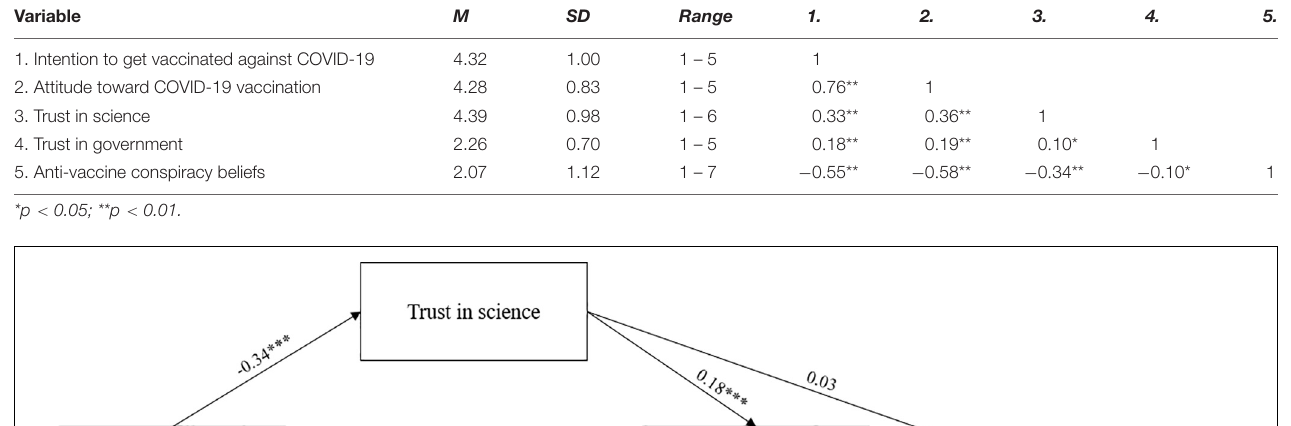
TABLE 1 | Descriptive statistics and Pearson’s correlations among the psychological variables. Variable M SD